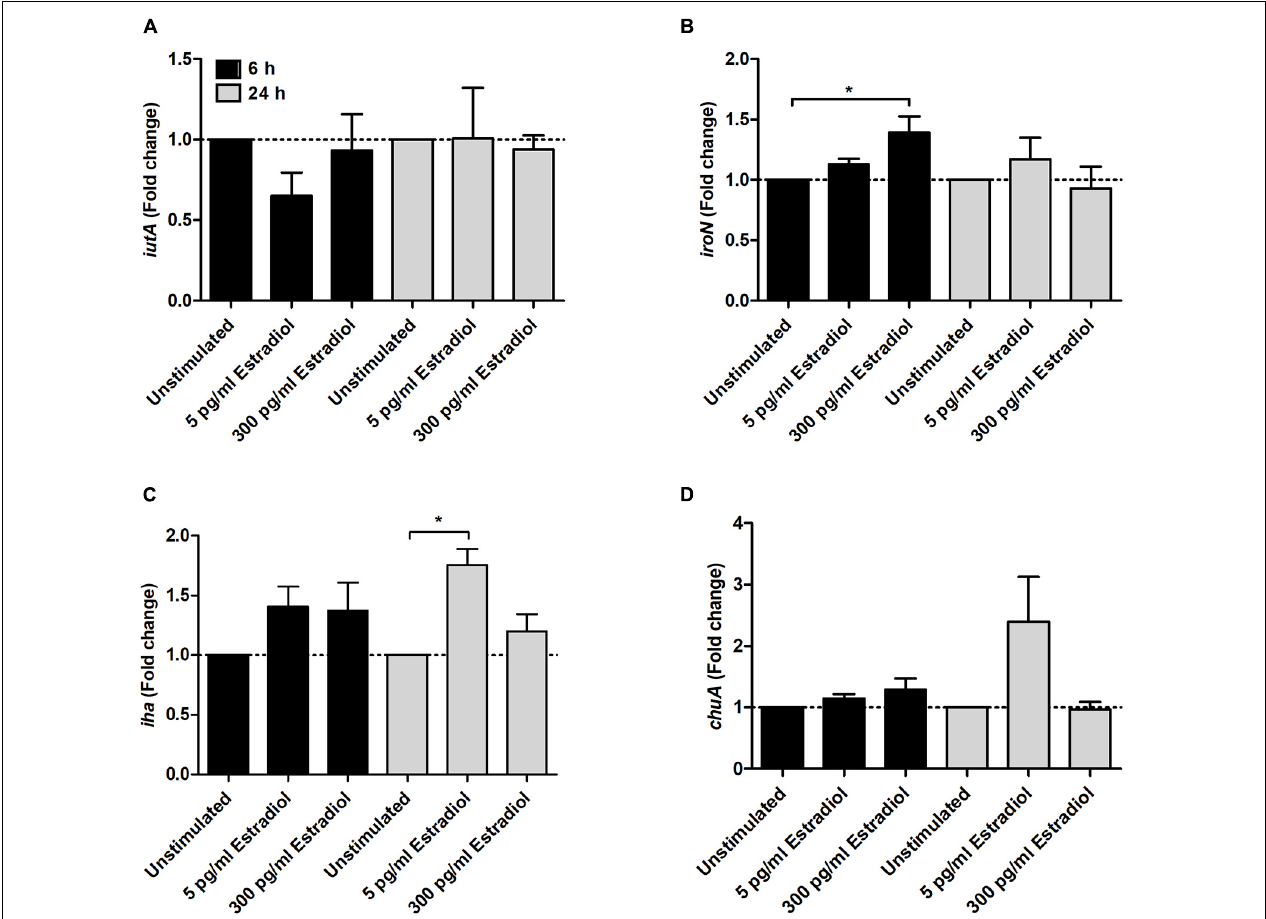
FIGURE 4 | Real-time qPCR analysis of iutA (A) , iroN (B) , iha (C) , and chuA (D) gene expression in the presence or absence of estradiol (5 and 300 pg/ml) at 6 and 24 h. Data are presented as mean ± SEM of n = 3 independent experiments. The asterisks distinguish statistical significance: * p < 0.05 vs. unstimulated